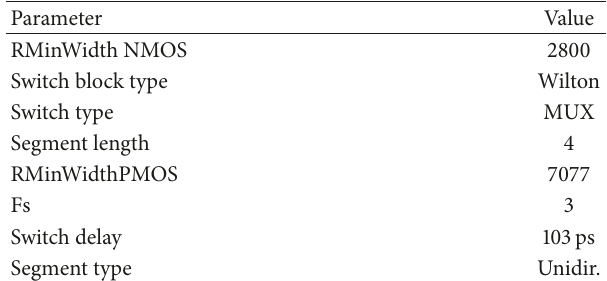
Table 1: Architecture file